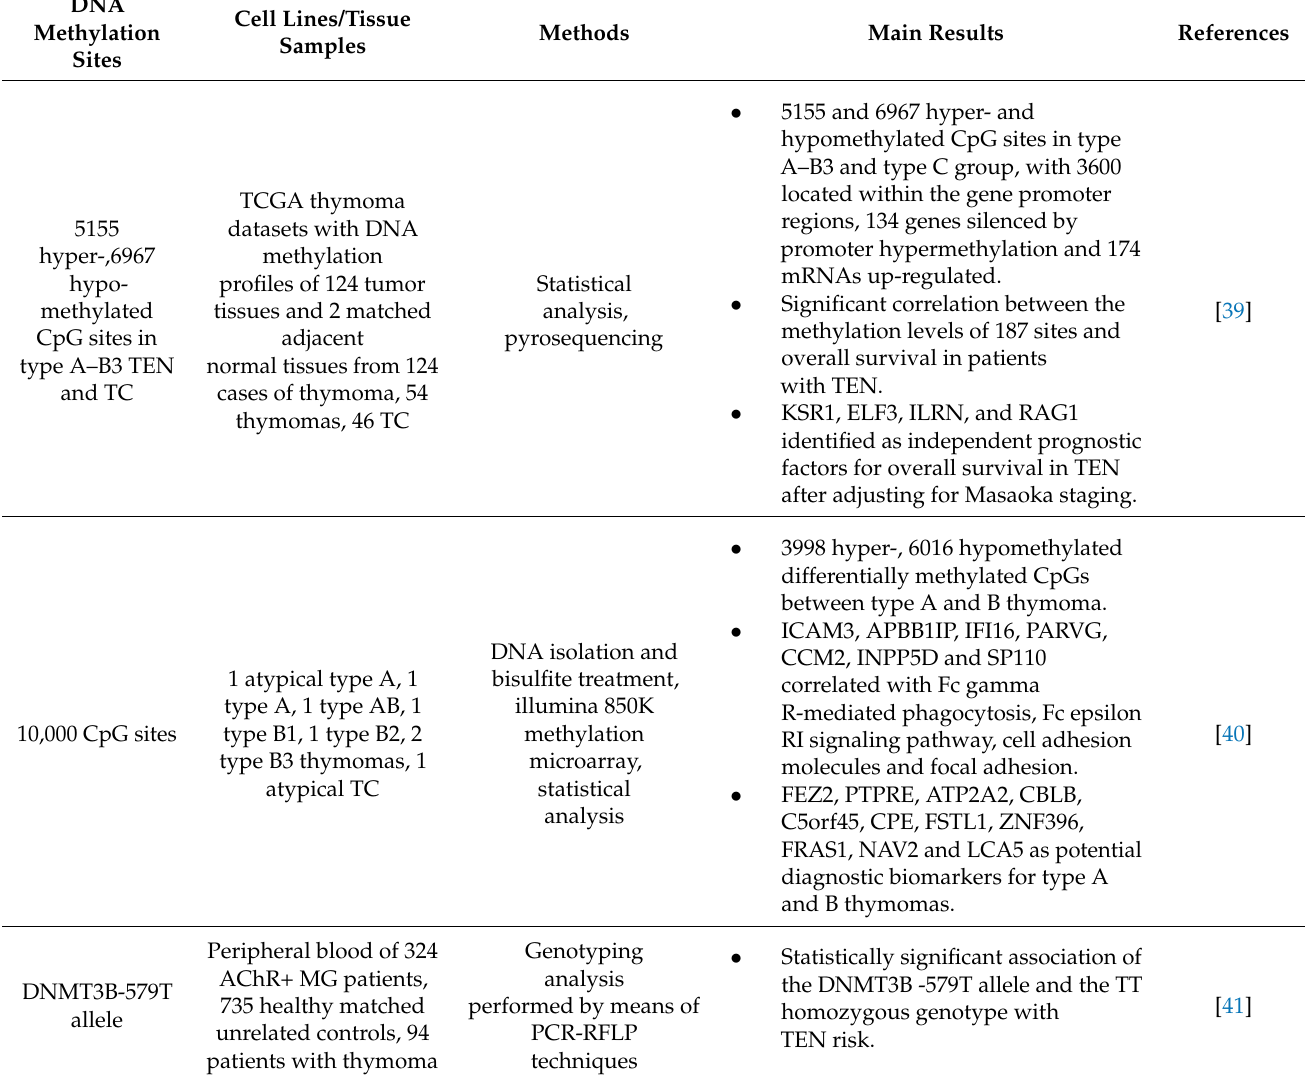
Table 2. Alterations of DNA methylation in